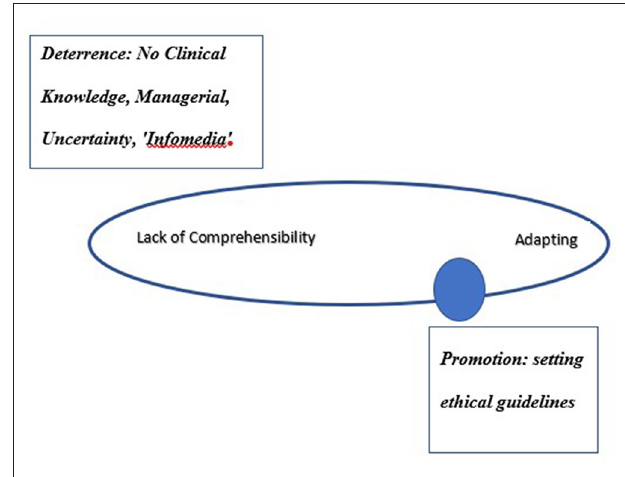
FIGURE 1 | The dynamic sphere of resilience on the comprehensibility